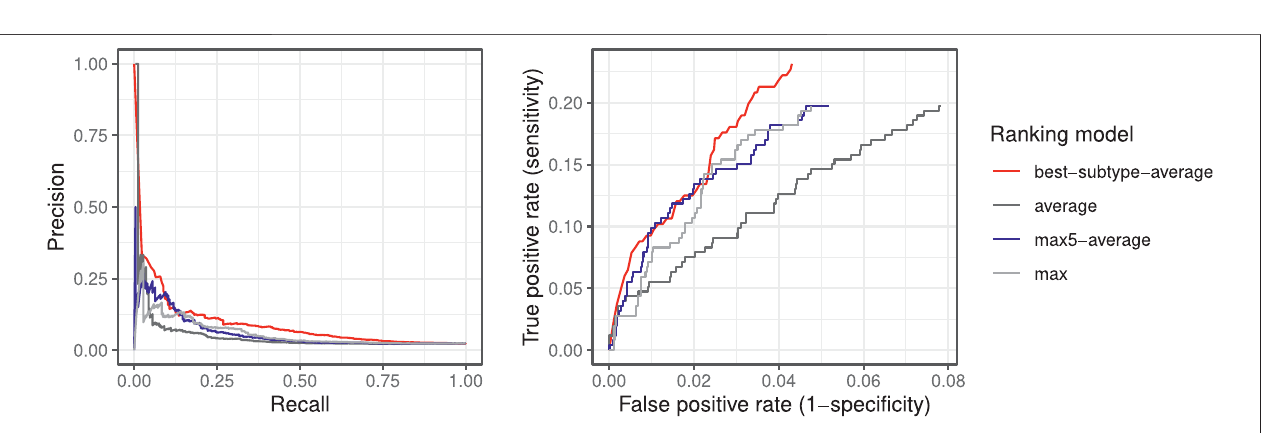
FIGURE 6 | Precision-recall curves and the partial ROC curves for different ranking models.